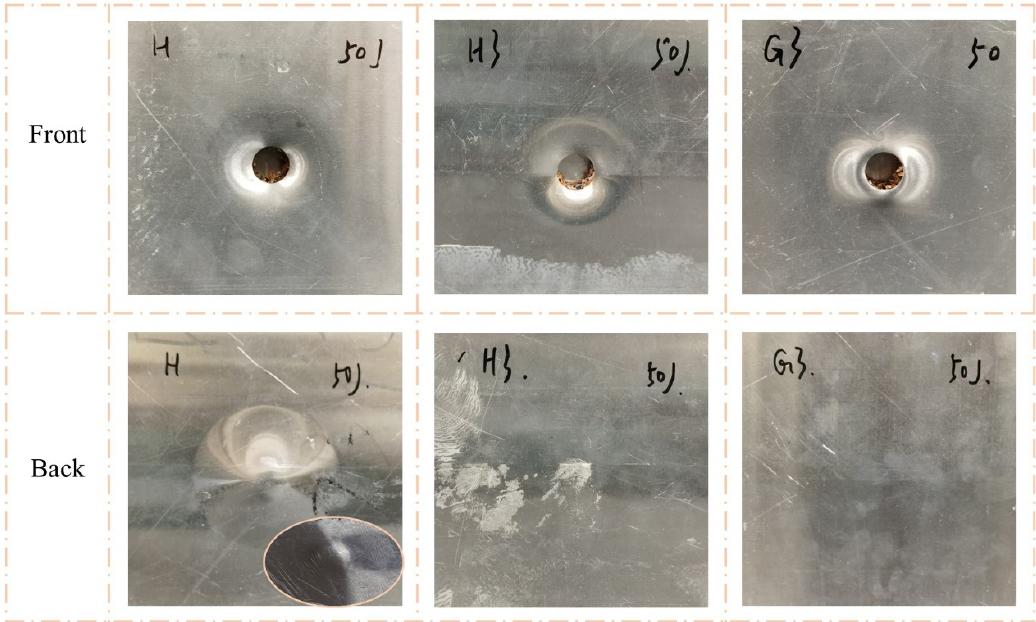
Figure 13. Damage modes of H, H3, and G3 under 50 J impact energy with flat impactor.